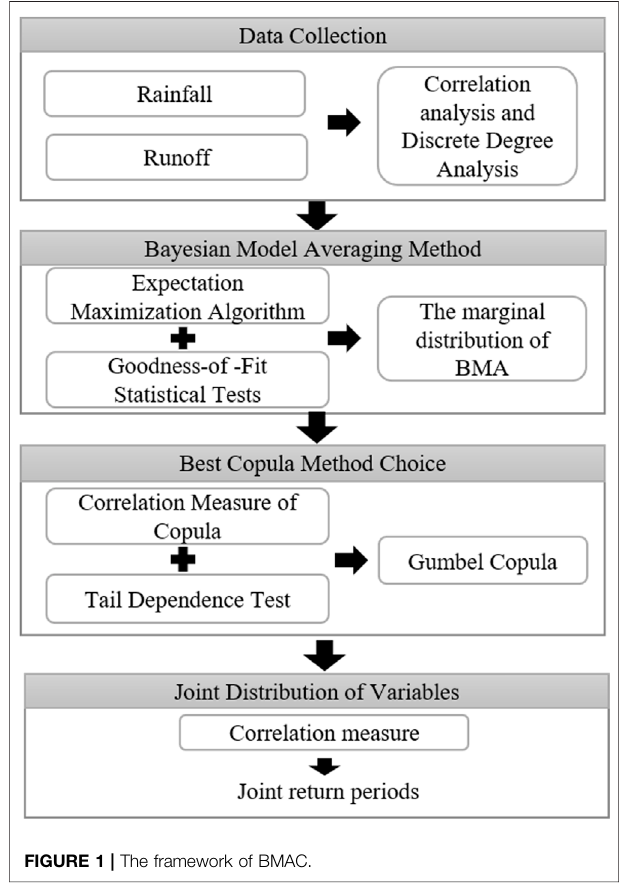
FIGURE 1 | The framework of